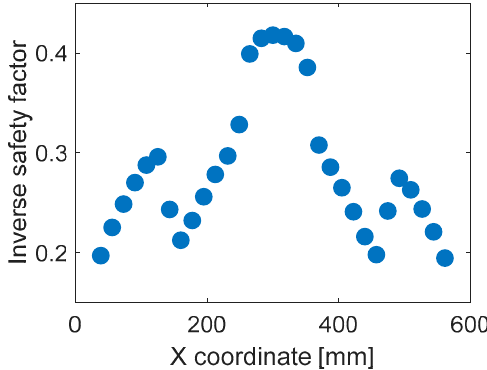
Figure 3. Generated data samples of ISF (inverse safety factor) for example force value of 40 N.